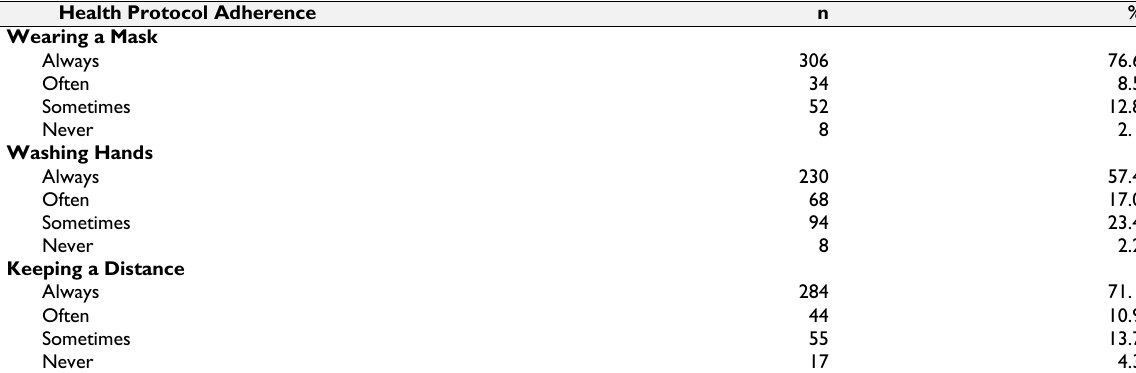
Table 2 Distribution of health protocol adherence (N = 400) Health Protocol Adherence